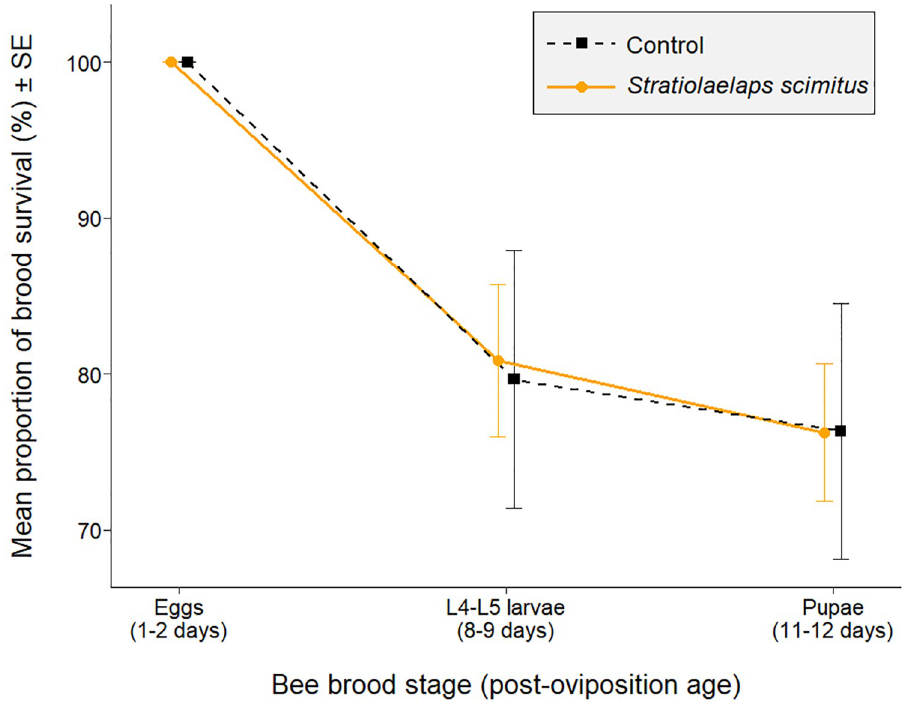
Fig 4. Effect of the inoculation of honey bee colonies (n = 5) with � 12,500 Stratiolaelaps scimitus individuals on the mean proportion of bee brood survival from the eggs to the pupae in comparison with untreated colonies (control; n = 3). On average, 1800 ± 111 (mean ± SE) eggs have been marked in each colony and monitored over time (August 09 to 21, 2017). There was no effect of the treatment on the bee brood survival (repeated measures ANOVA; F (1,6) = 0.03, p =